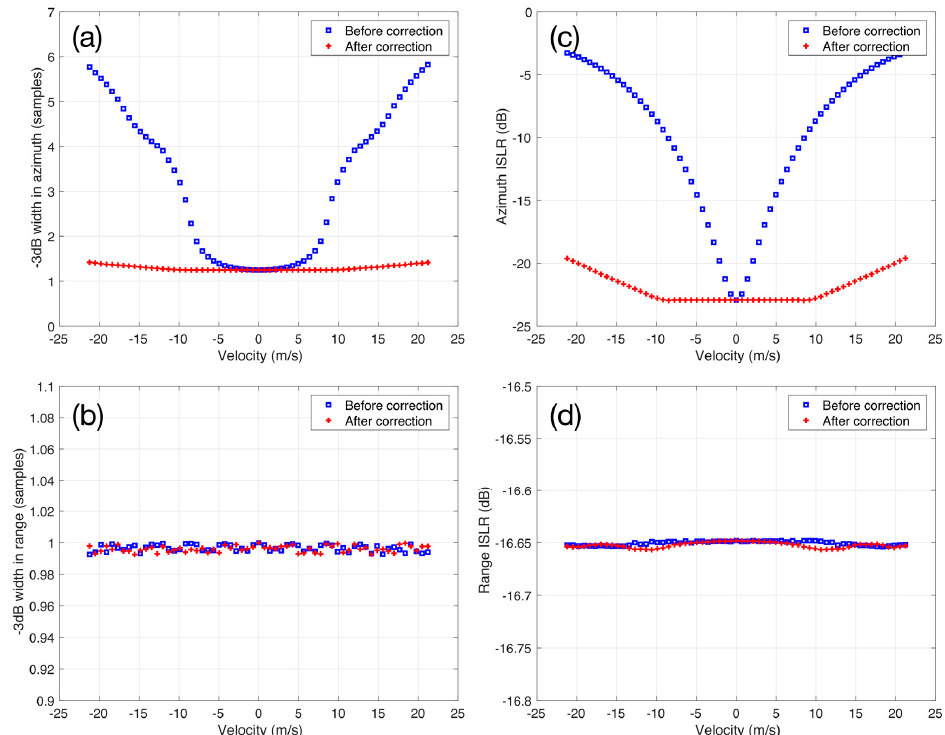
Figure 4. Simulation results of the − 3 dB width and the integrated sidelobe ratio (ISLR) in the ( a , c ) azimuth and ( b , d ) range directions, respectively. The simulation was carried out using system parameters of the TerraSAR-X stripmap mode (see Table 1). The improvement in the azimuth direction is significant particularly up to about 8 m/s (or 28.8 km/h).